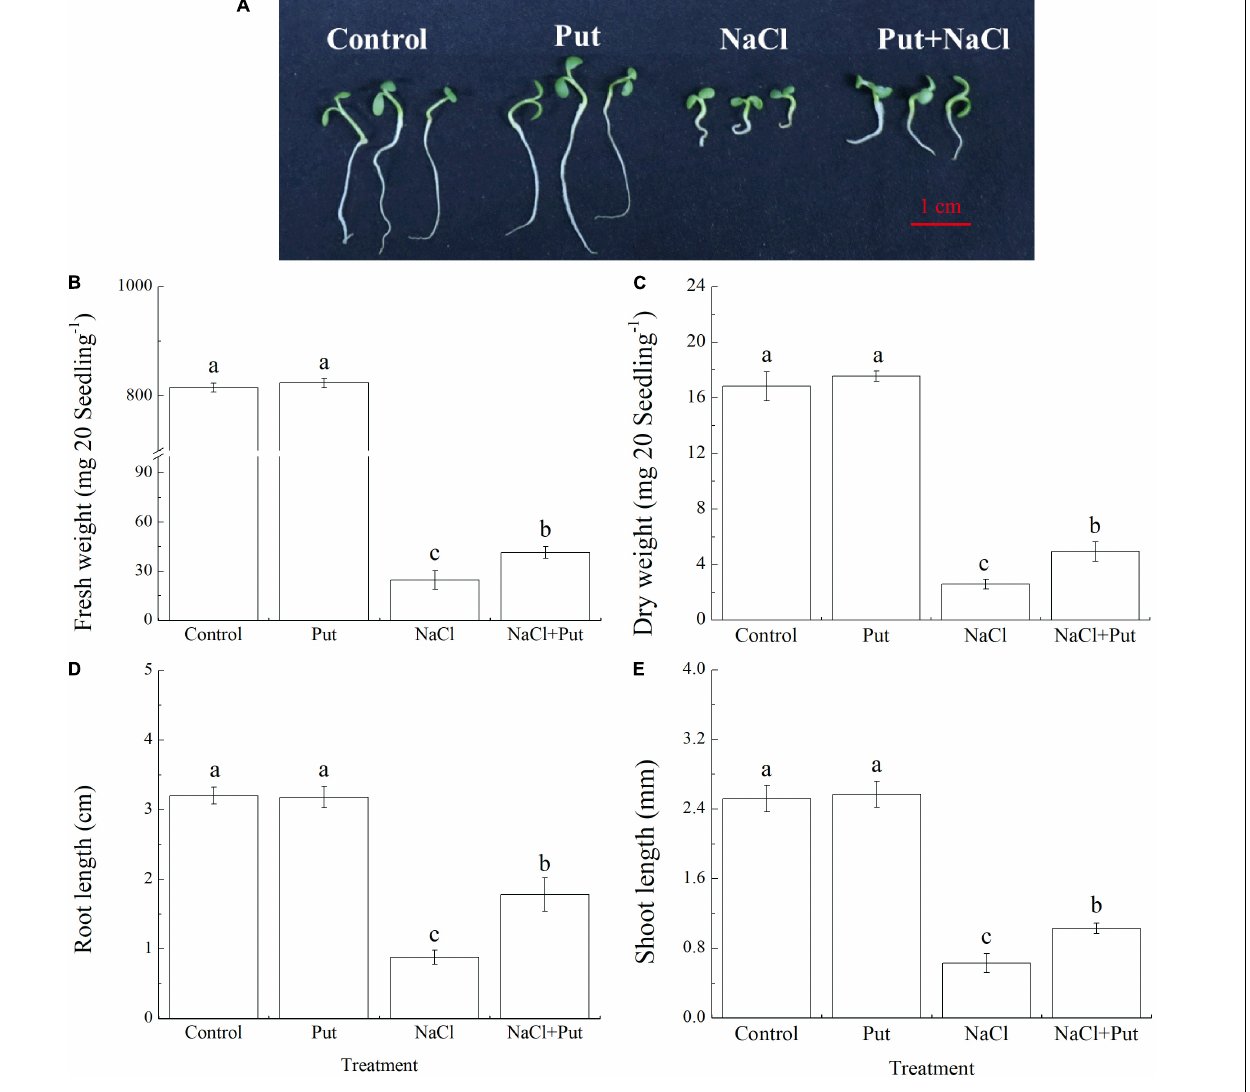
FIGURE 1 | Effects of seed soaking with Put or water on (A) phenotypic changes, (B) fresh weight, (C) dry weight, (D) root length, and (E) shoot length of white clover seedlings after 7 days of germination under normal condition and salt stress. Vertical bars indicate ± SE of means ( n = 4). Different letters above columns indicate significant differences. LSD ( P ≤